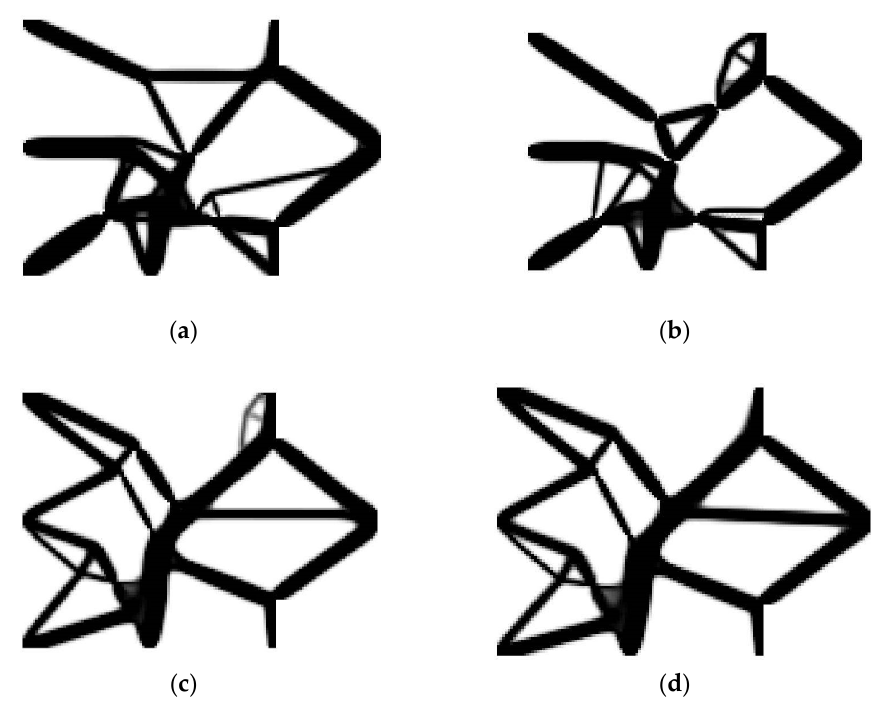
Figure 15. Inverters obtained with different [ δ ] and [ γ ]: ( a ) 0.1, ( b ) 0.01, ( c ) 0.001, ( d ) 0.0001.